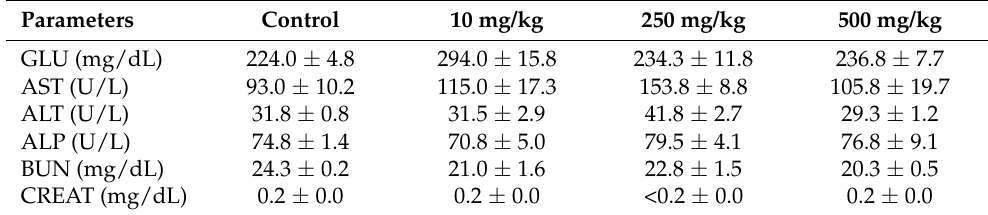
Table 3. Comparison of PsA versus vehicle control-treated hematological biochemical parameters glucose (GLU), aspartate aminotransferase (AST), alanine aminotransferase (ALT), alkaline phos- phatase (ALP), blood urea nitrogen (BUN), and creatinine (CREAT) in male Swiss albino mice. Data shown as mean ± SEM for n = 5/sex/group. Parameters